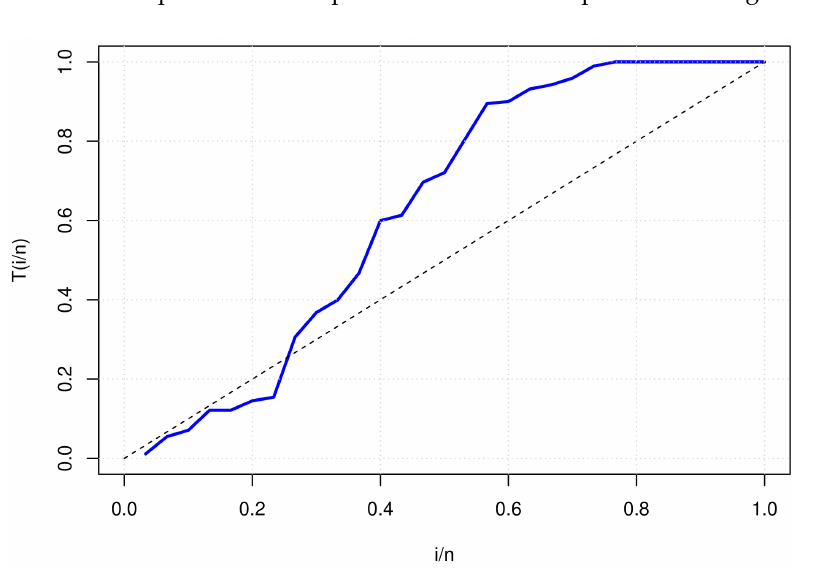
Figure 5. TTT plot for Data presented in Table